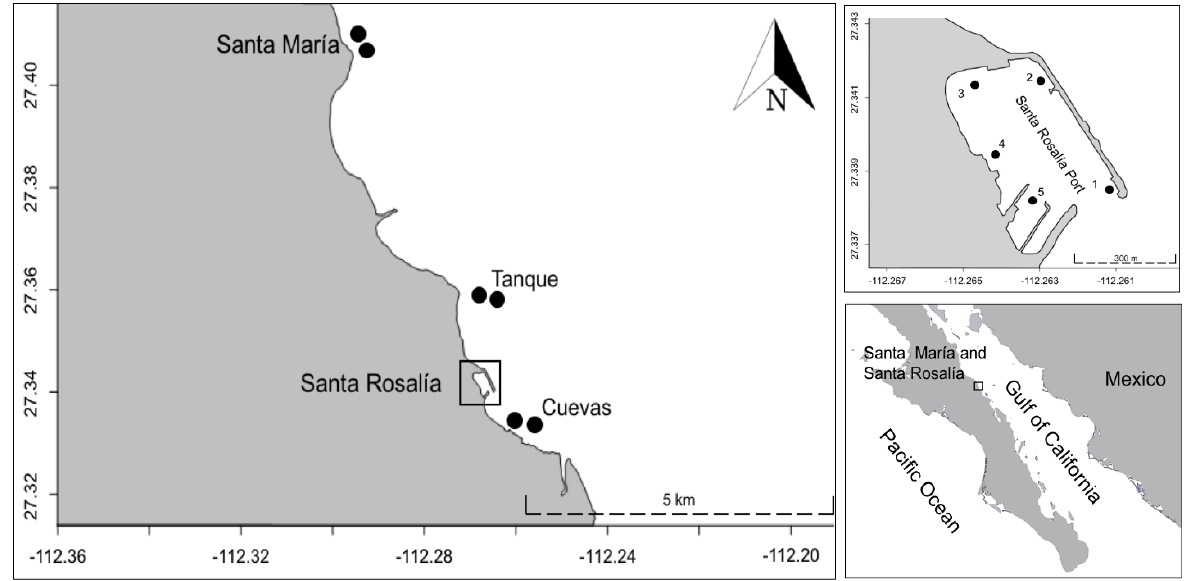
Figure 1. Location of study area (Santa Rosalia) and control site (Santa María).